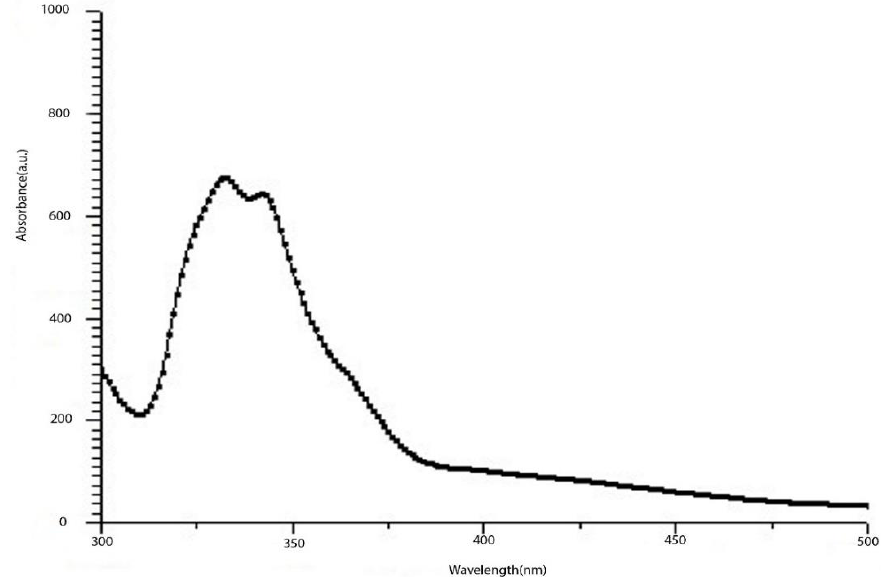
Figure 6. PL spectra of the La 2 ZnO 4 nanocomposite.